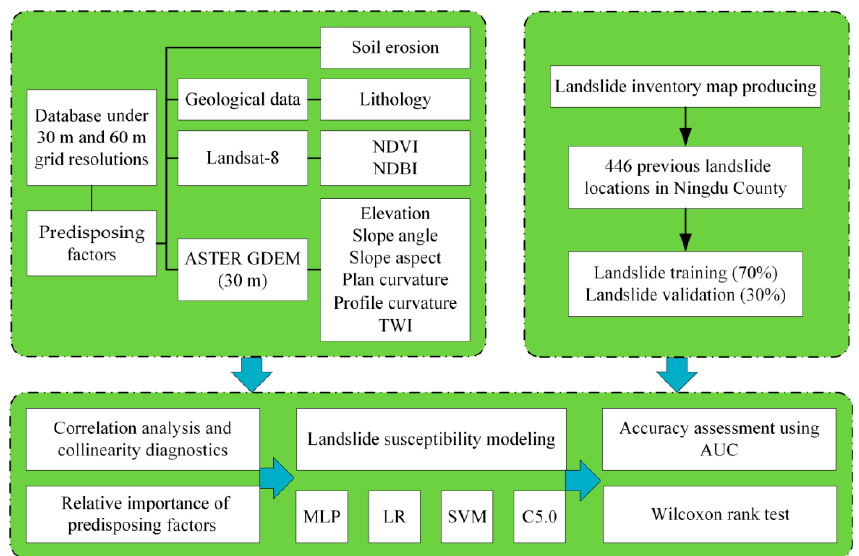
Figure 3. Flowchart of this study.